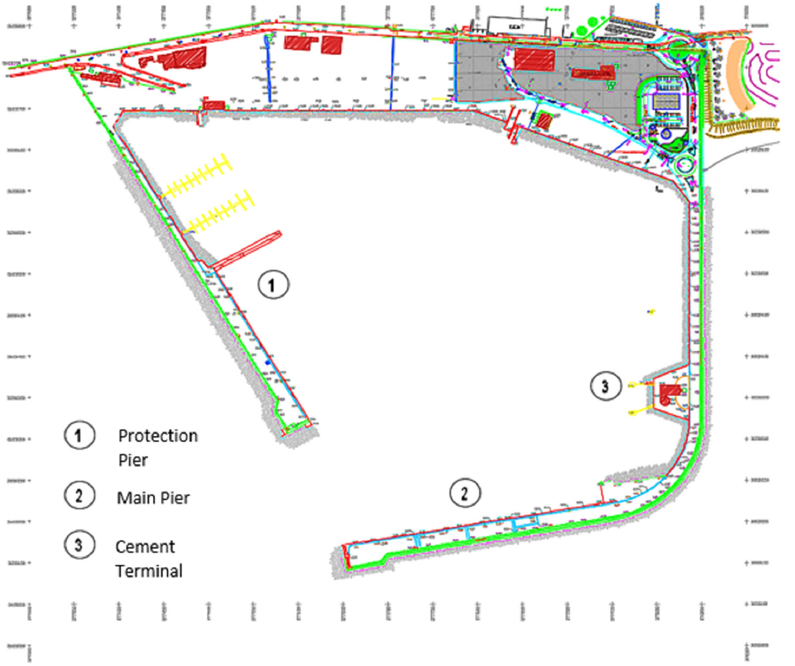
Figure 3. Port of Porto Santo Island (Plan). (Adapted from: APRAM - Administração dos Portos da Região Autónoma da Madeira, S. A.).